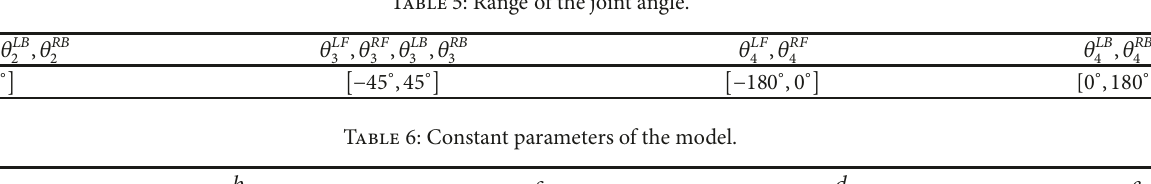
Table 5: Range of the joint angle.